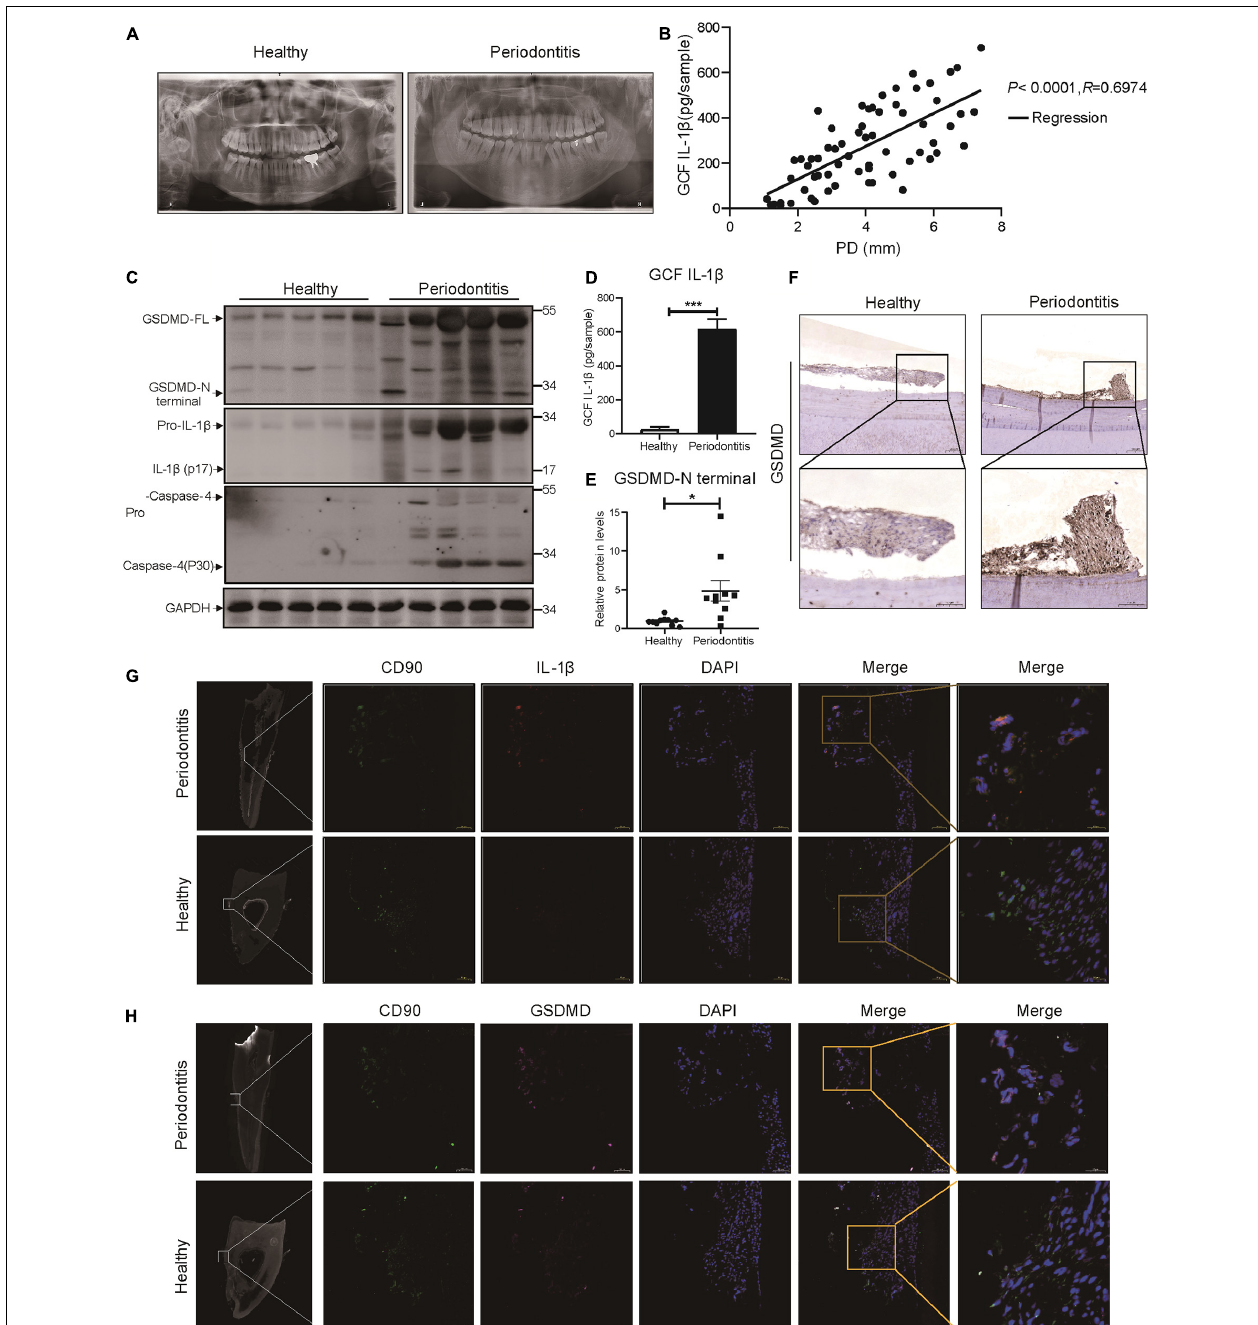
FIGURE 1 | The inflammatory lesions in periodontitis were correlated with the pyroptosis of PDLSCs. (A) Panoramic radiograph from healthy and periodontitis patients. (B) Scatter plot and regression line for the regression between GCF IL-1b level and probing depth (PD) from periodontitis patients ( n = 65). (C) Periodontium tissues were collected from periodontitis patients and healthy individuals, and the expression of GSDMD, IL-1 β , and Caspase-4 was analyzed by western blot. GAPDH was used as the loading control. (D) GCF from healthy subjects and periodontitis patients was analyzed to determine the concentrations of human IL-1 β by ELISA. (E) The intensities of the GSDMD-N terminus were quantified using imaging software and normalized to that of GAPDH. Ten periodontium tissue specimens from periodontitis patients and healthy individuals were examined. (F) Representative immunohistochemical staining of GSDMD in human periodontal ligament sections from healthy and periodontitis patients. The signals of GSDMD appear brown in sections counterstained with hematoxylin (blue). Experiments were repeated independently more than three times. (G) Immunofluorescence staining of CD90 (green) and IL-1 β (red) in human tooth longitudinal sections from severe periodontitis patients and healthy (orthodontic) patients. (H) Immunofluorescence staining of CD90 (green) and GSDMD (purple) in human tooth longitudinal sections from severe periodontitis patients and healthy patients. Nuclei were identified by staining with DAPI. Scale bars, 50 µ m. The data are presented as the mean ± SEM. * P < 0.05, *** P <